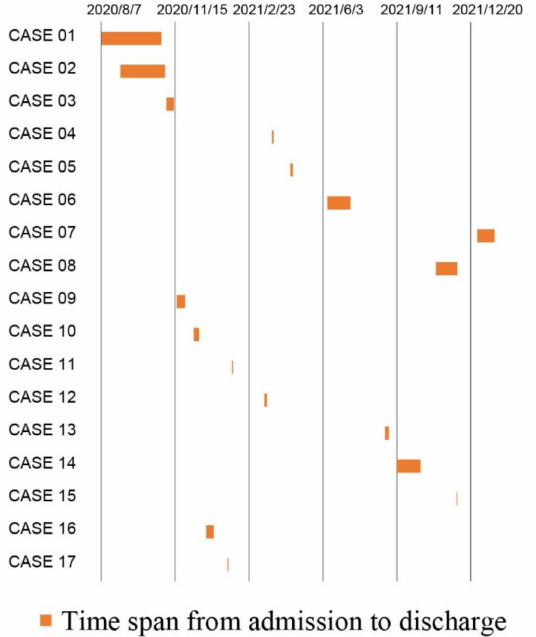
Figure 1. Distribution of length of stay for all the ESLD patients with CRE colonization in this